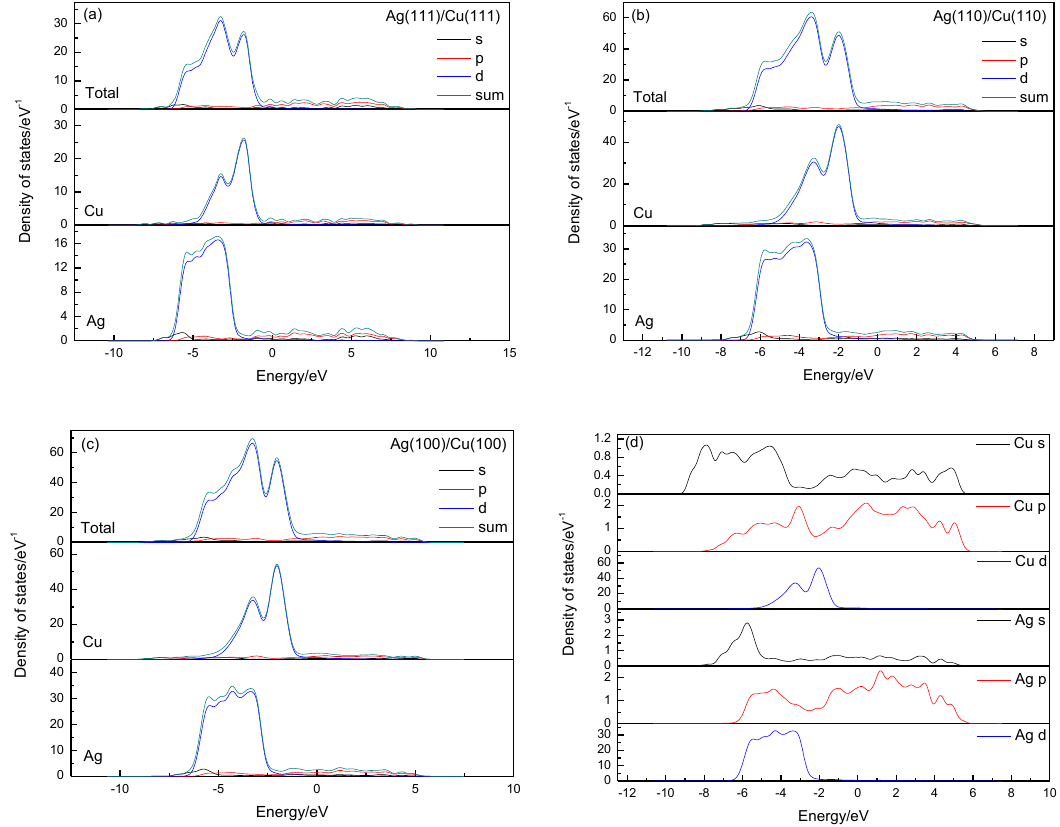
Figure 3. Density of states of the interface of Cu / Ag composite. ( a ) PDOS of Ag(111) / Cu(111); ( b ) PDOS of Ag(110) / Cu(110); ( c ) PDOS of Ag(100) / Cu(100); ( d ) PDOS of Cu and Ag atoms in Ag(100) / Cu(100).